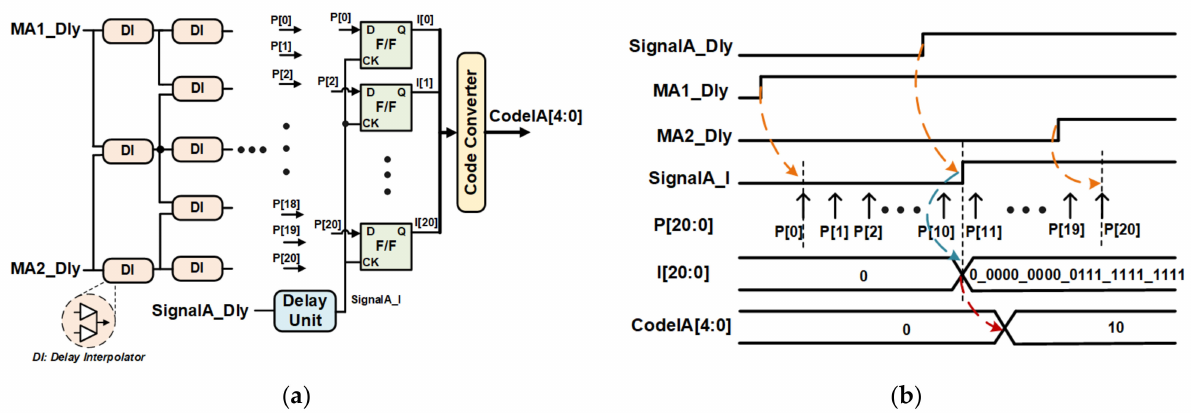
Figure 8. ( a ) Circuit diagram of the interpolation circuit (Signal A); ( b ) Operation waveform of the interpolation